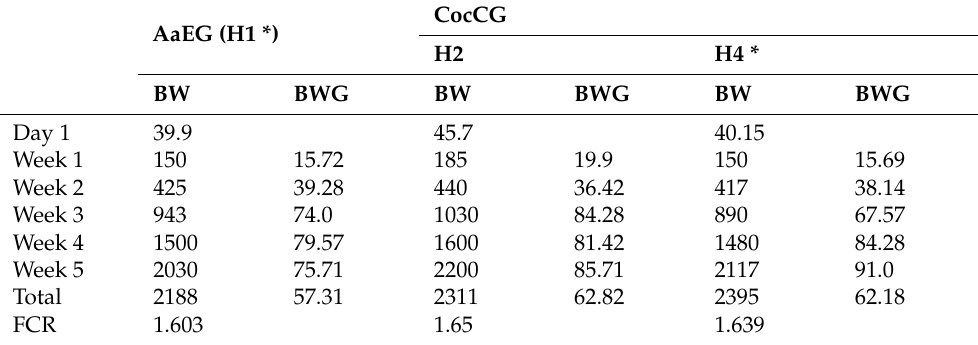
Table 4. Body weight (BW) (g), body weight gain (BWG) (g/day), and feed conversion ratio (FCR) (kg feed/kg weight) in broiler chickens fed with A. annua diet compared with chickens fed with in-feed